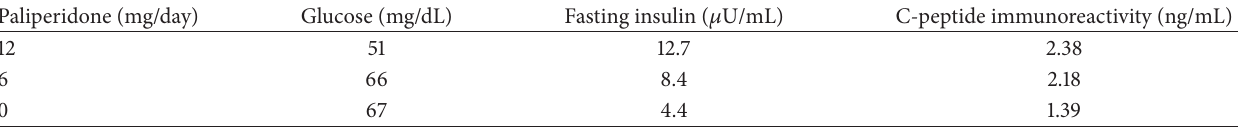
Table 1: Dose-dependent changes in glucose, fasting insulin level, and C-peptide